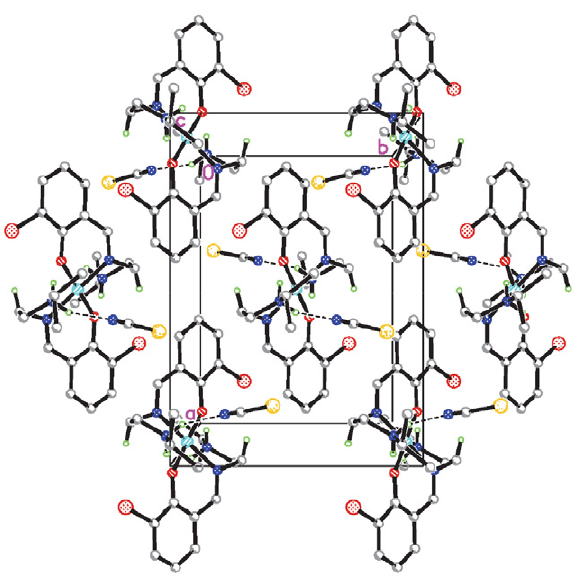
Figure 5. Molecular packing structure of complex 2 , viewed along the c axis. Hydrogen bonds are shown as dashed lines.